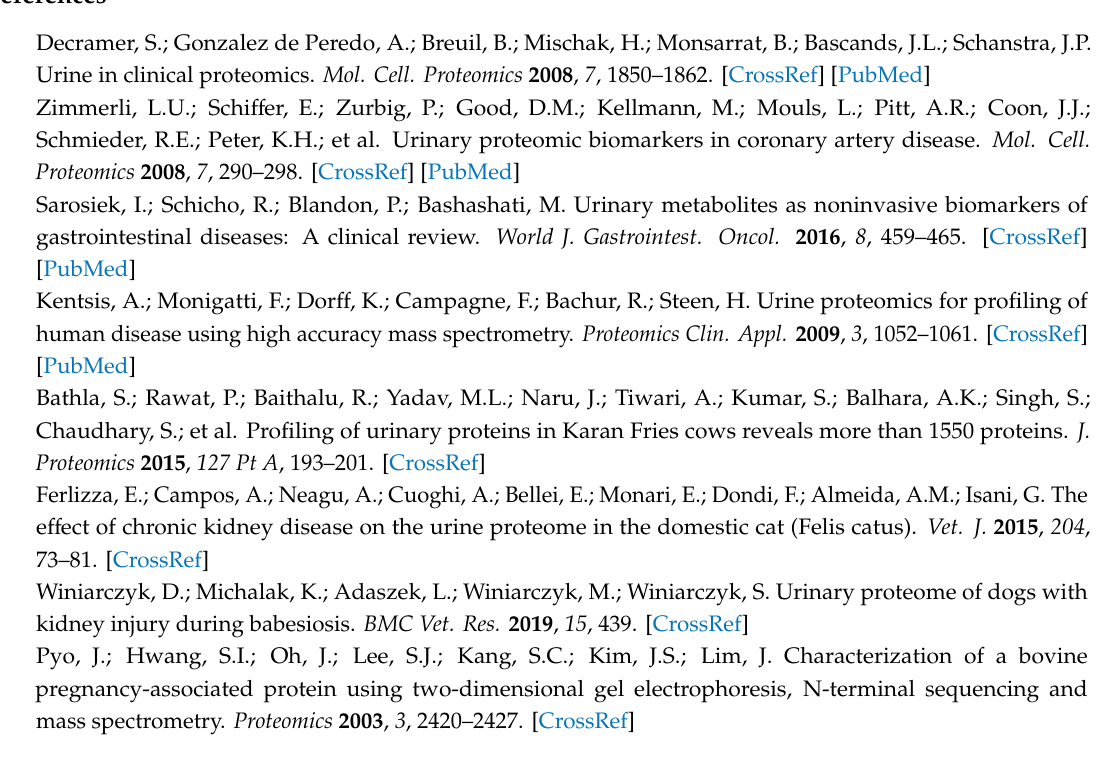
Table S1. Summary of protein identification from the urine of 6 days old calves identified using MALDI-TOF-TOF-MS / MS, Table S2. Summary of protein identification from the urine of 6 days old calves identified using LC-MS / MS ORBITRAP mass spectrometer, Table S3. Subcellular localization and biological function of calf urinary proteome components, Table S4. Most abundant proteins respective bands of calves’ urine identified using LC-MS / MS ORBITRAP mass spectrometer, Figure S1. Overlap between the 2D gel and 1D LC-MSMS